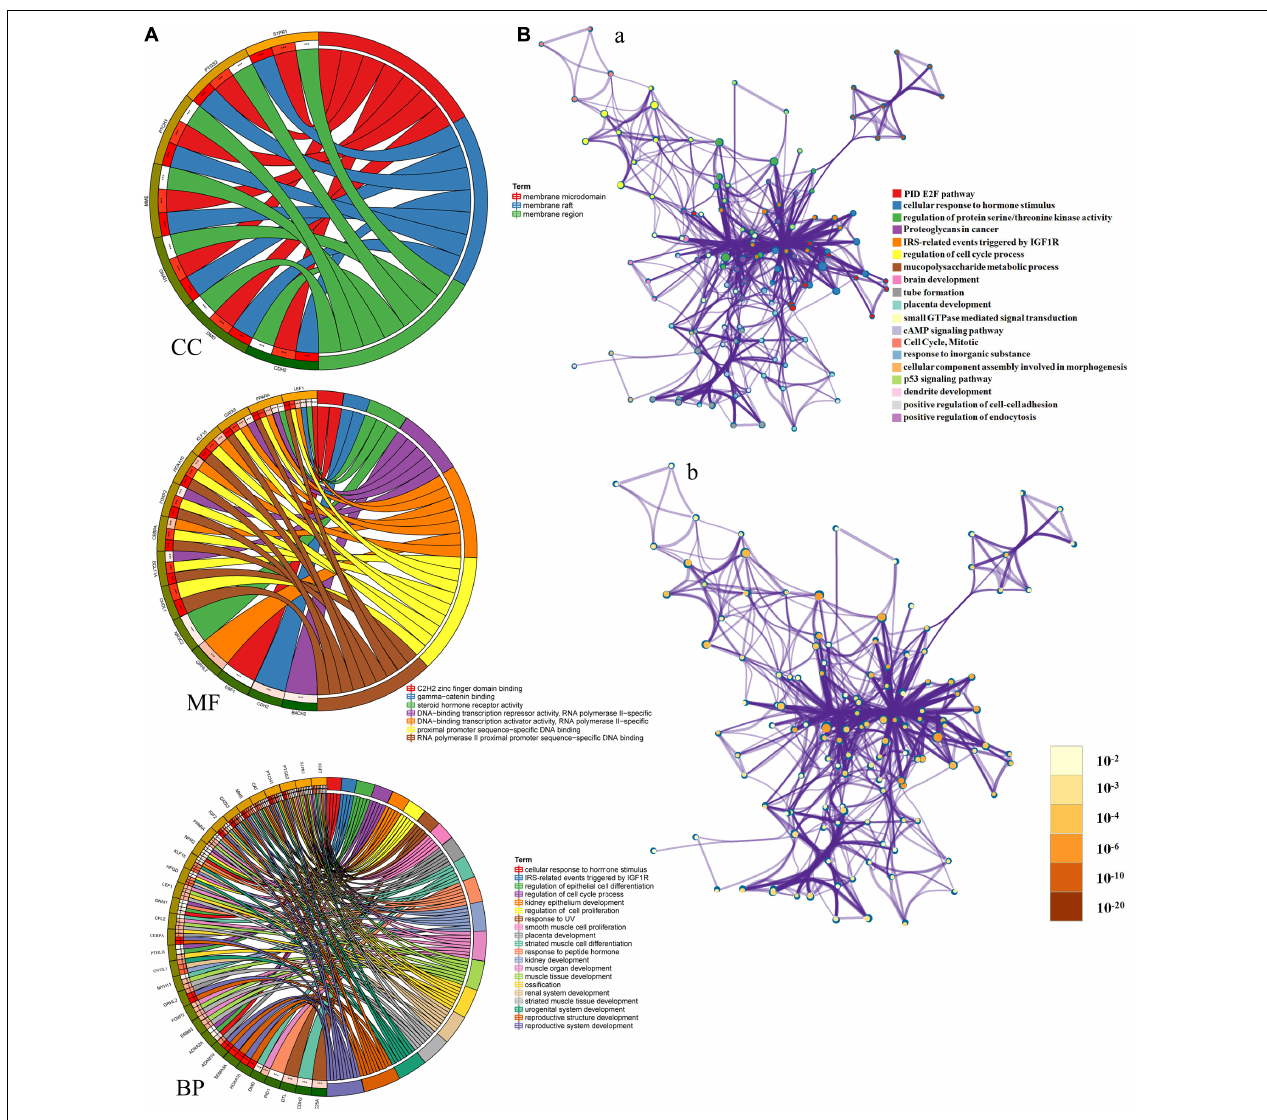
FIGURE 5 | (A) Gene Ontology (GO) enrichment analysis of hub mRNAs in the PPI network was performed using Sangerbox (http://sangerbox.com/). CC, Cell components; MF, Molecular function; BP, Biological processes. (B) Interaction network of GO and Kyoto Encyclopedia of Genes and Genomes (KEGG) enriched terms using Metascape. (a) Colored by cluster ID, where nodes that share the same cluster ID are typically close to each other; (b) colored by p -value, where terms containing more genes tend to have a more significant p